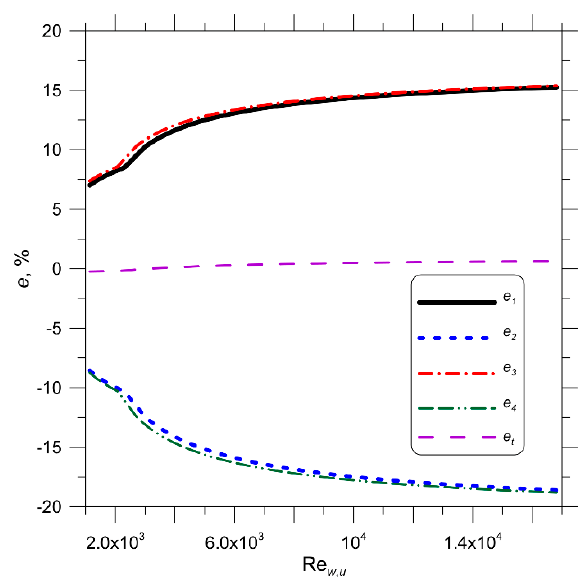
e and e between thermal outputs of individual tube rows and Figure 11. The relative differences i t Figure 11. The relative di ff erences e i and e t between thermal outputs of individual tube rows and the the entire car radiator for different and uniform HTCs calculated using Equations (55) and (56); entire car radiator for di ff erent and uniform HTCs calculated using Equations (55) and (56); w 0 = 2.27 (cid:48) (cid:48) = 8.24 ◦ C, and T = 70.56 ◦ m / s, T am w